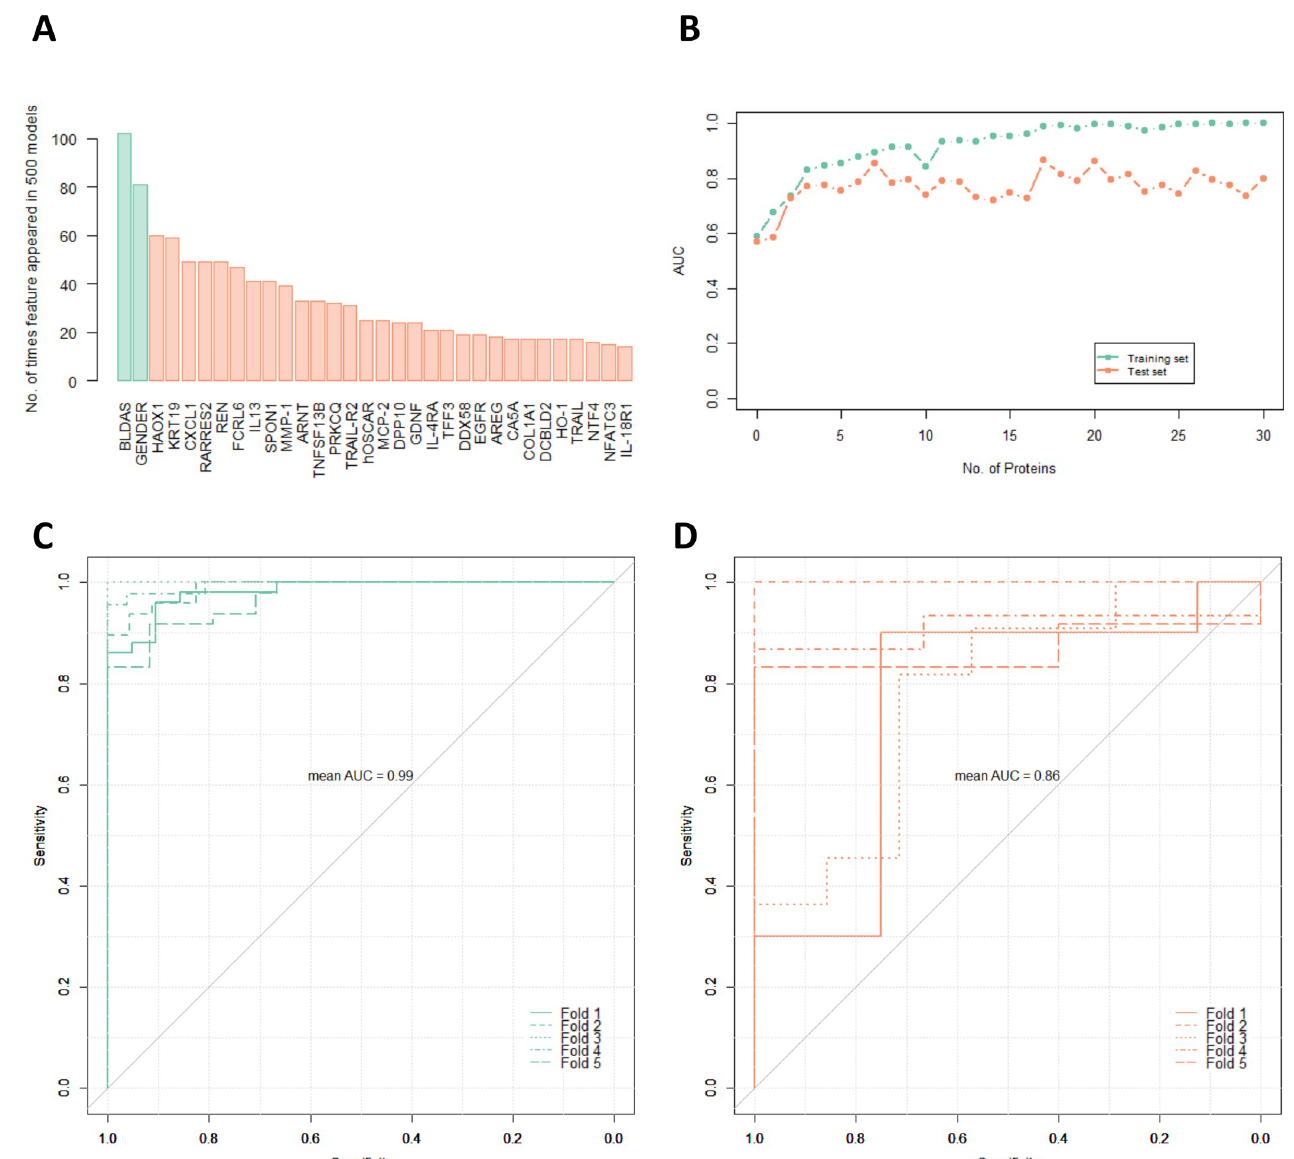
Fig 3. (A) Feature importance of top 30 proteins along with significant demographic and clinical features, viz. gender and base line disease activity score (BLDAS). (B) Area Under the Curve (AUC) of training and test set vs. number of protein features. A set of 17 proteins along with gender and BLDAS gave the maximum mean AUC of 0.86 on test set without decreasing the training set’s AUC. Receiver Operator Characteristics (ROC) for the 5-fold cross-validation using gender, BLDAS, and 17 protein features of (C) training sets and corresponding (D) test